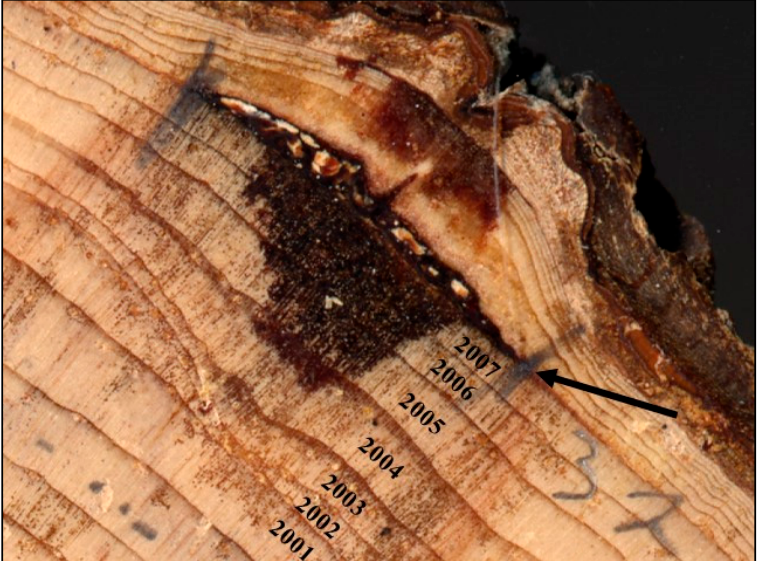
Figure 2. Cross-section of a white pine tree documenting annual rings and canker 32. Canker 32 formed in the earlywood of 2008 (black arrow) and had no recovery year, as annual ring width continued to decline post-canker.